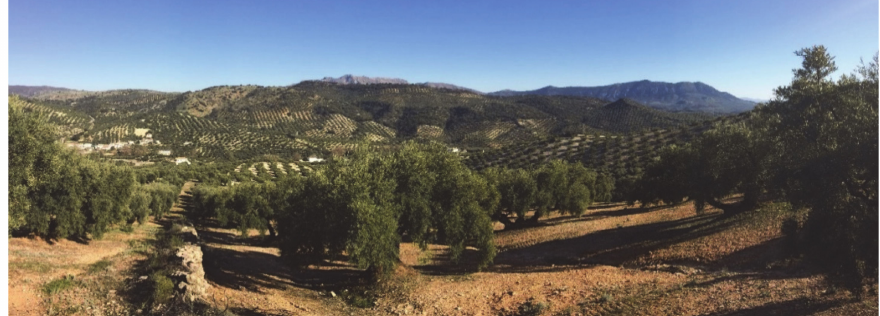
Figure 3. The traditional olive trees landscape in the Mediterranean Basin. Olive cultivation is part of the history, culture, landscape, and economy of this region. It is a tree crop well adapted to Mediterranean climatic